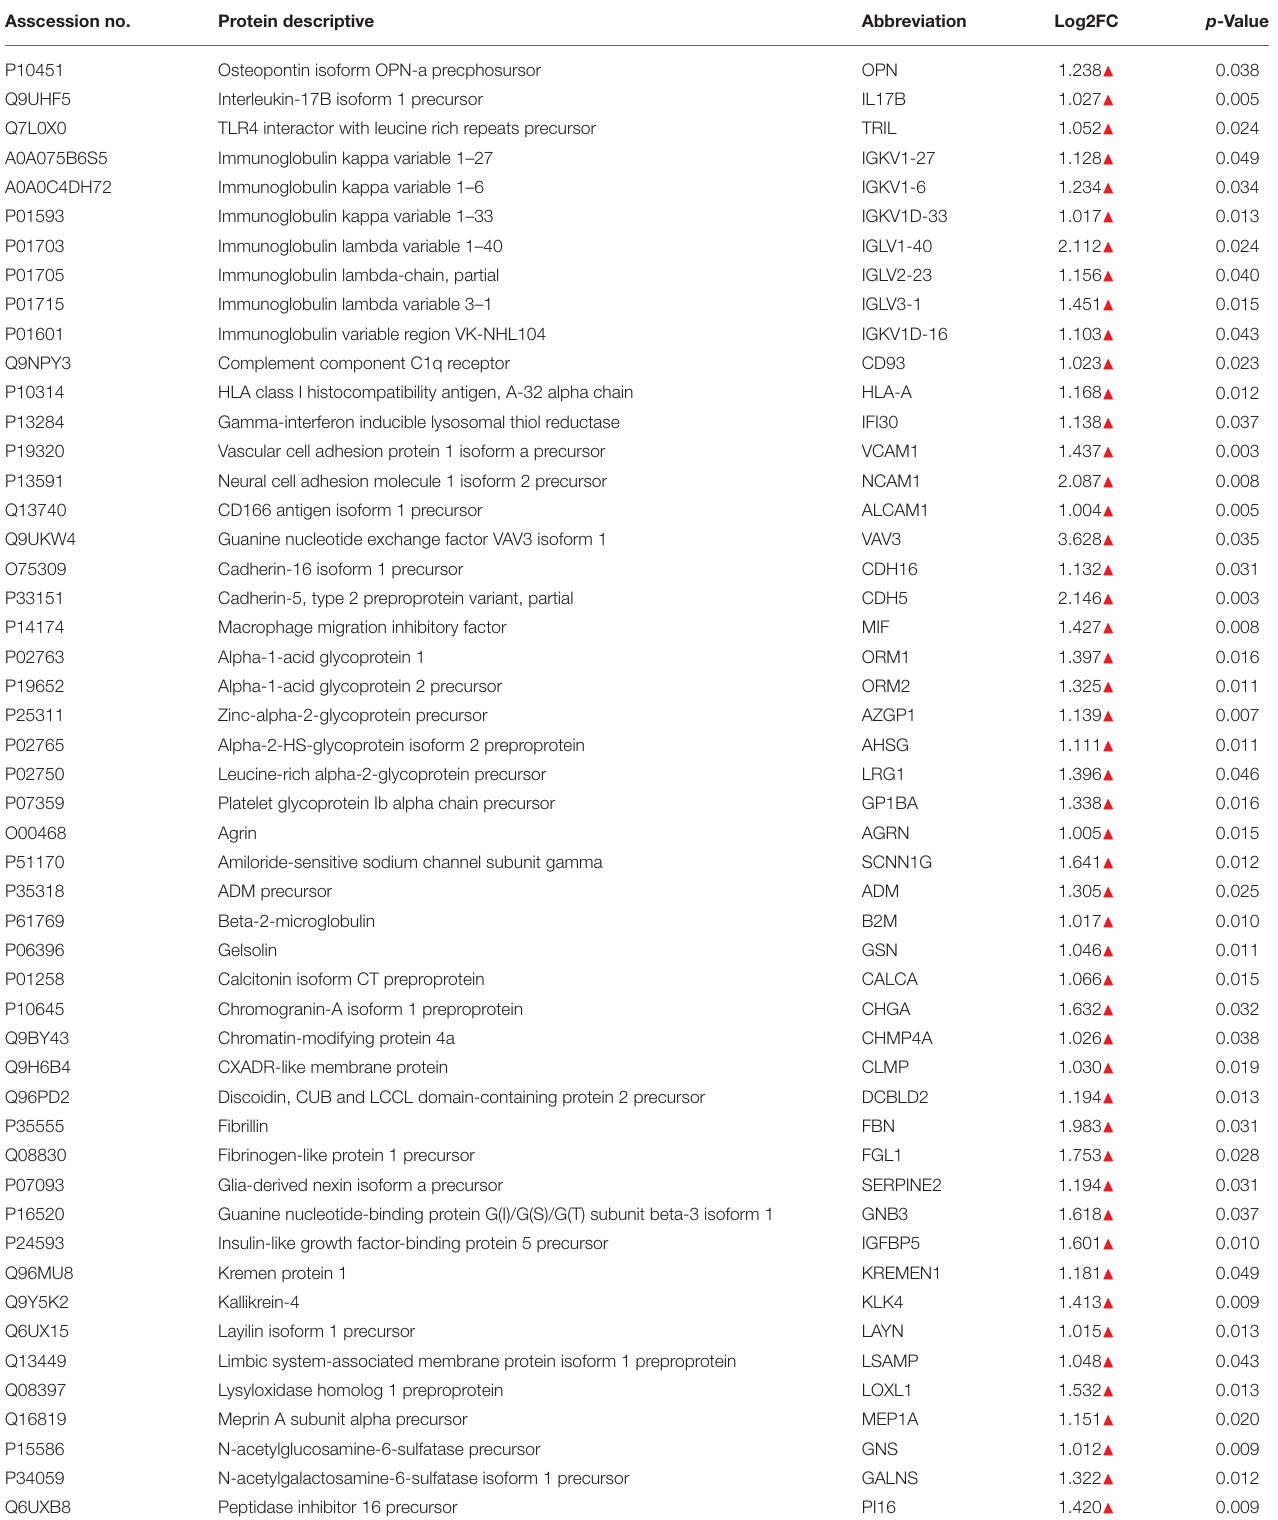
TABLE 2 | List of differentially expressed proteins. Asscession